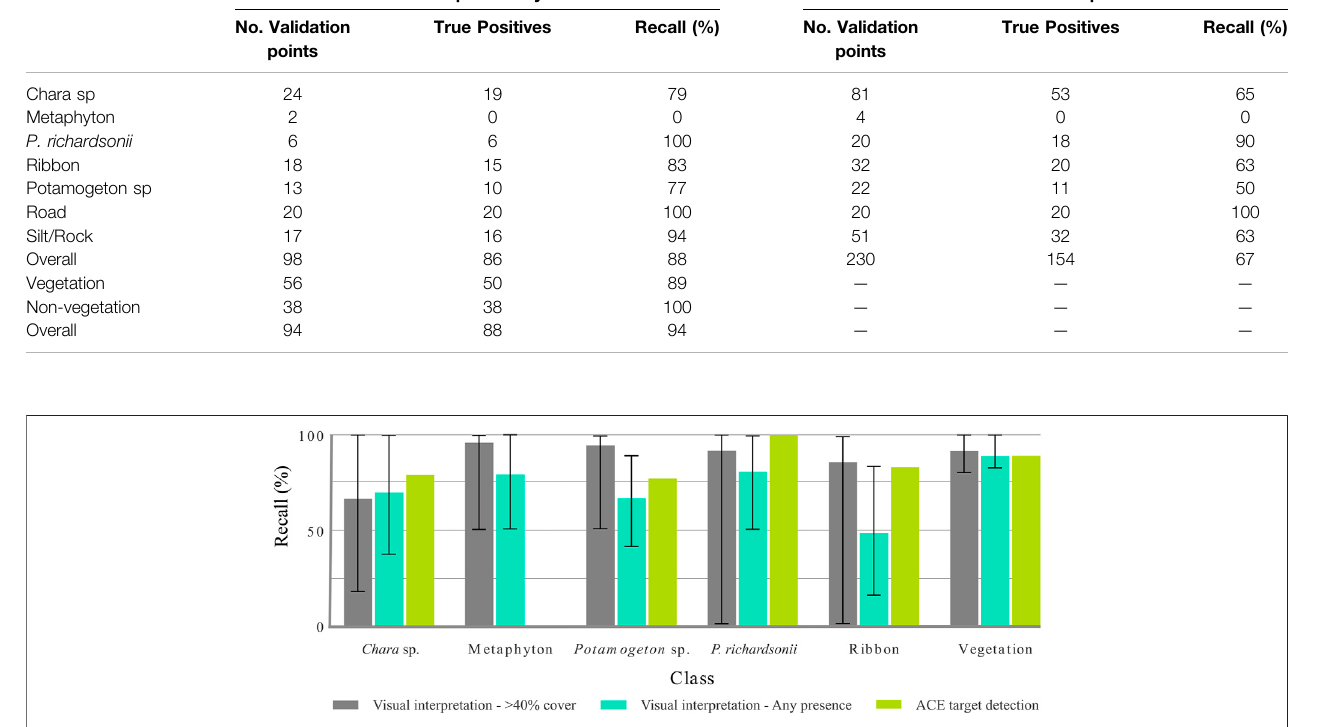
FIGURE11| Comparisonofrecallresultsfromvisualinterpretation,forboth40%classcoverandanyinstanceofclasspresence,andCASIairbornehyperspectral image target detection. The range of responses is shown by the error bars for visual interpretation results.